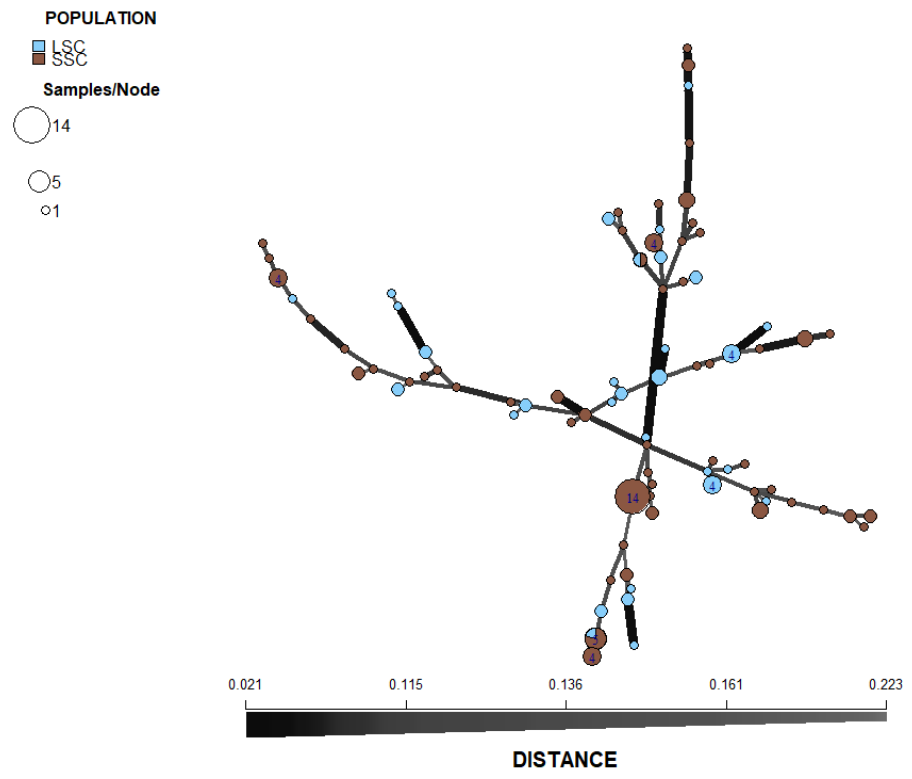
Figure 9. Minimum spanning network (MSN) inferred from simple sequence repeat (SSR) markers of P. infestans (non-clone corrected) collected on large-scale conventional farm (LSC) and small-scale farm (SSC). Each node represents multilocus genotypes (MLGs) and the size is proportional to the number of individuals sharing the same SSR allele profile. The thickness of the lines represents the Bruvo’s genetic distance between two nodes (the further the genetic distance the lighter the color and thinner the line). MLGs from the same agricultural management practice are color-coded.